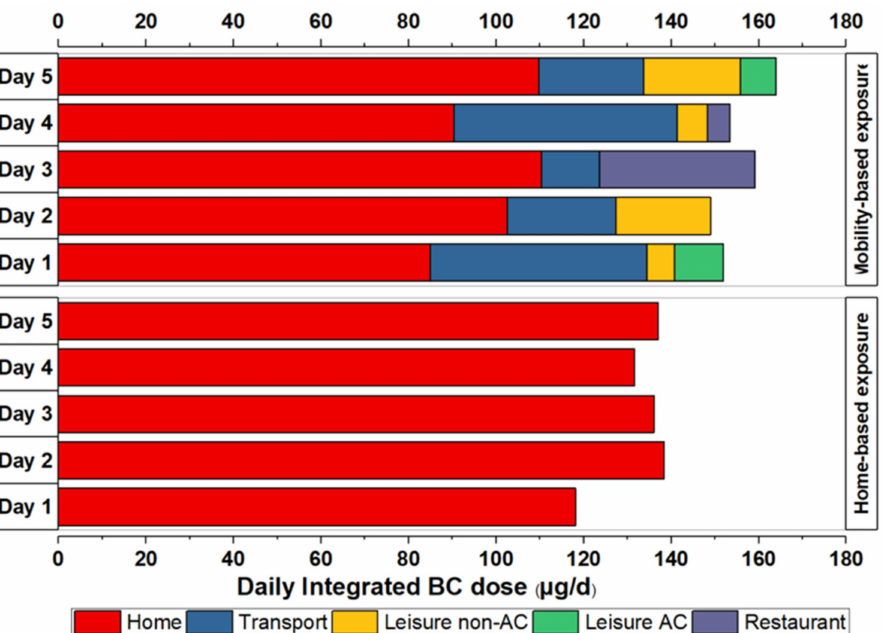
Figure 4. Daily integrated dose of BC during home-based exposure and during mobility-based exposure encompassing diverse MEs on representative days. Abbreviations: black carbon (BC), air conditioning (AC), microenvironments